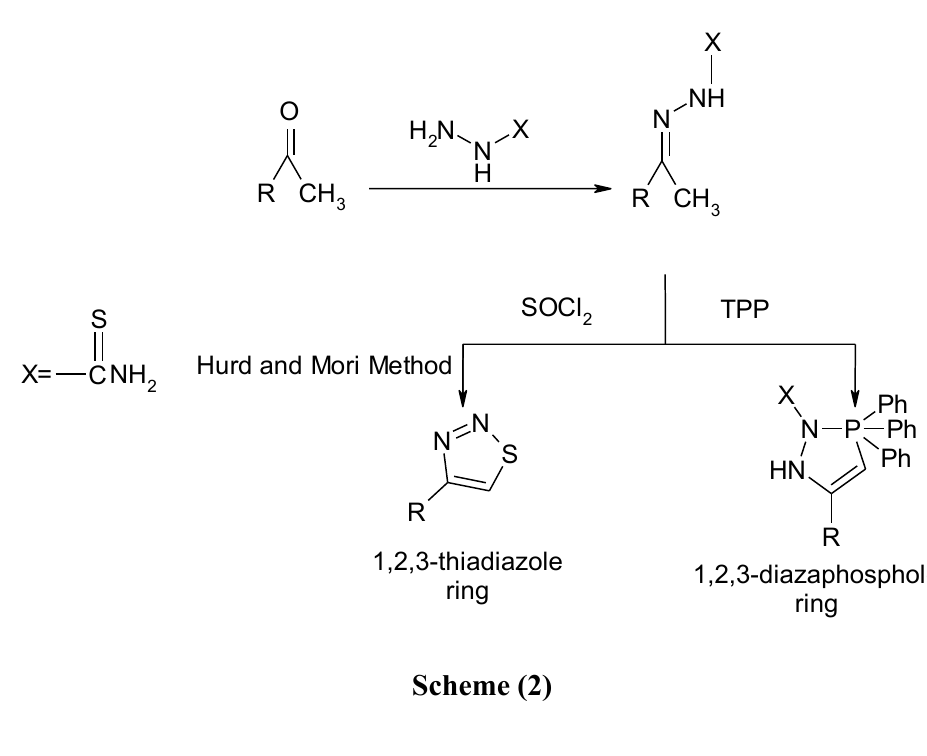
diazaphosphole derivatives are shown in scheme